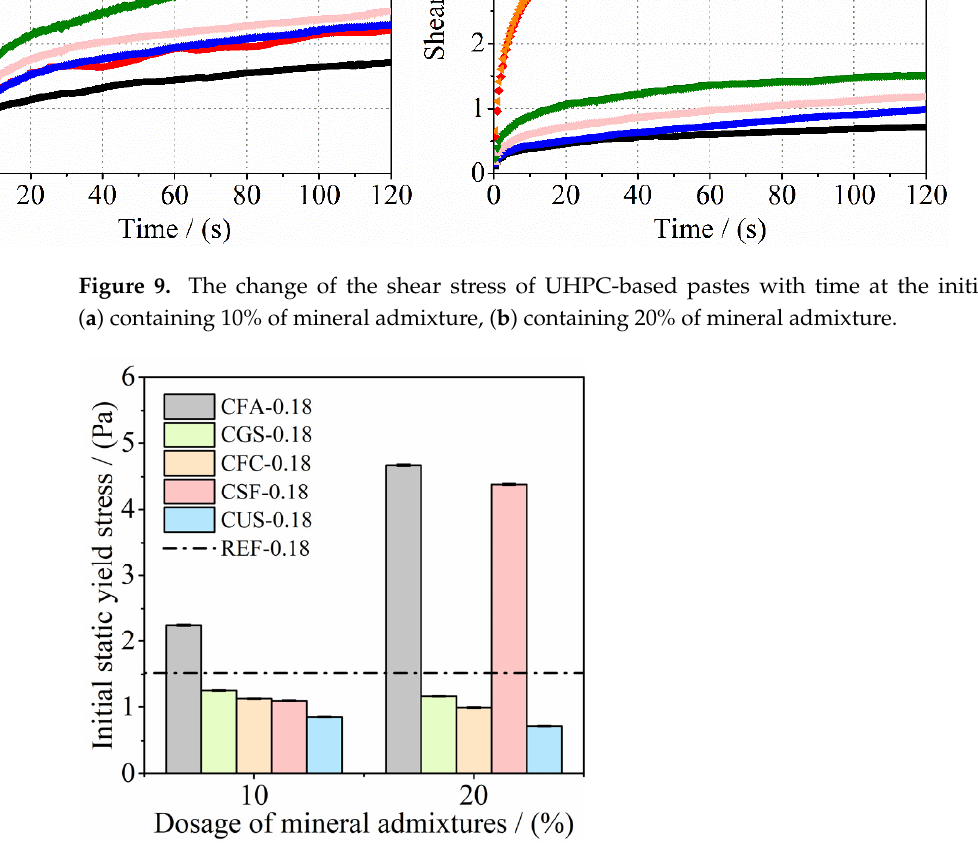
Figure 10. The initial static yield stress of UHPC-based pastes.